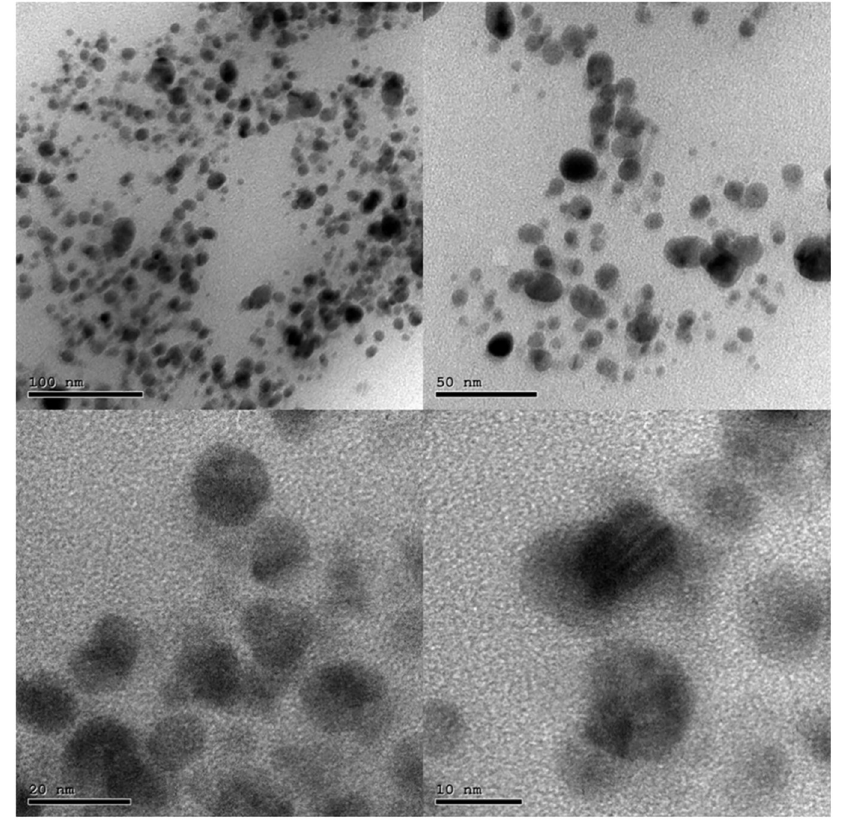
Fig 4. HRTEM image of silver